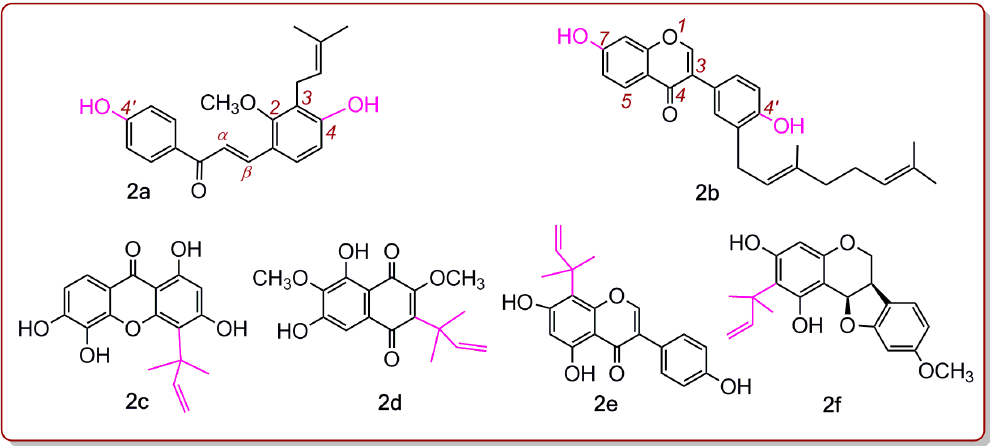
Figure 1. Structural formulas and molecular models of echinatin and licochalcone A: A , structural formula of echinatin; B , structural formula of licochalcone A; C , preferential conformation-based molecular model of echinatin; and D , preferential conformation-based molecular model of licochalcone A. The molecular models were created based on molecular mechanics calculations using Chem3D Pro 14.0. (red, O; gray, C; white, H).